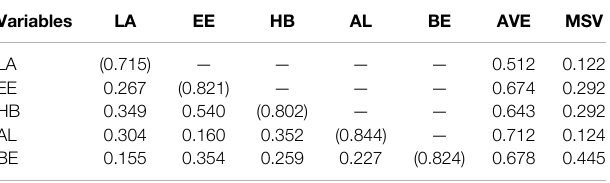
TABLE 2 | Demographic characteristics of the sample ( n = 169).